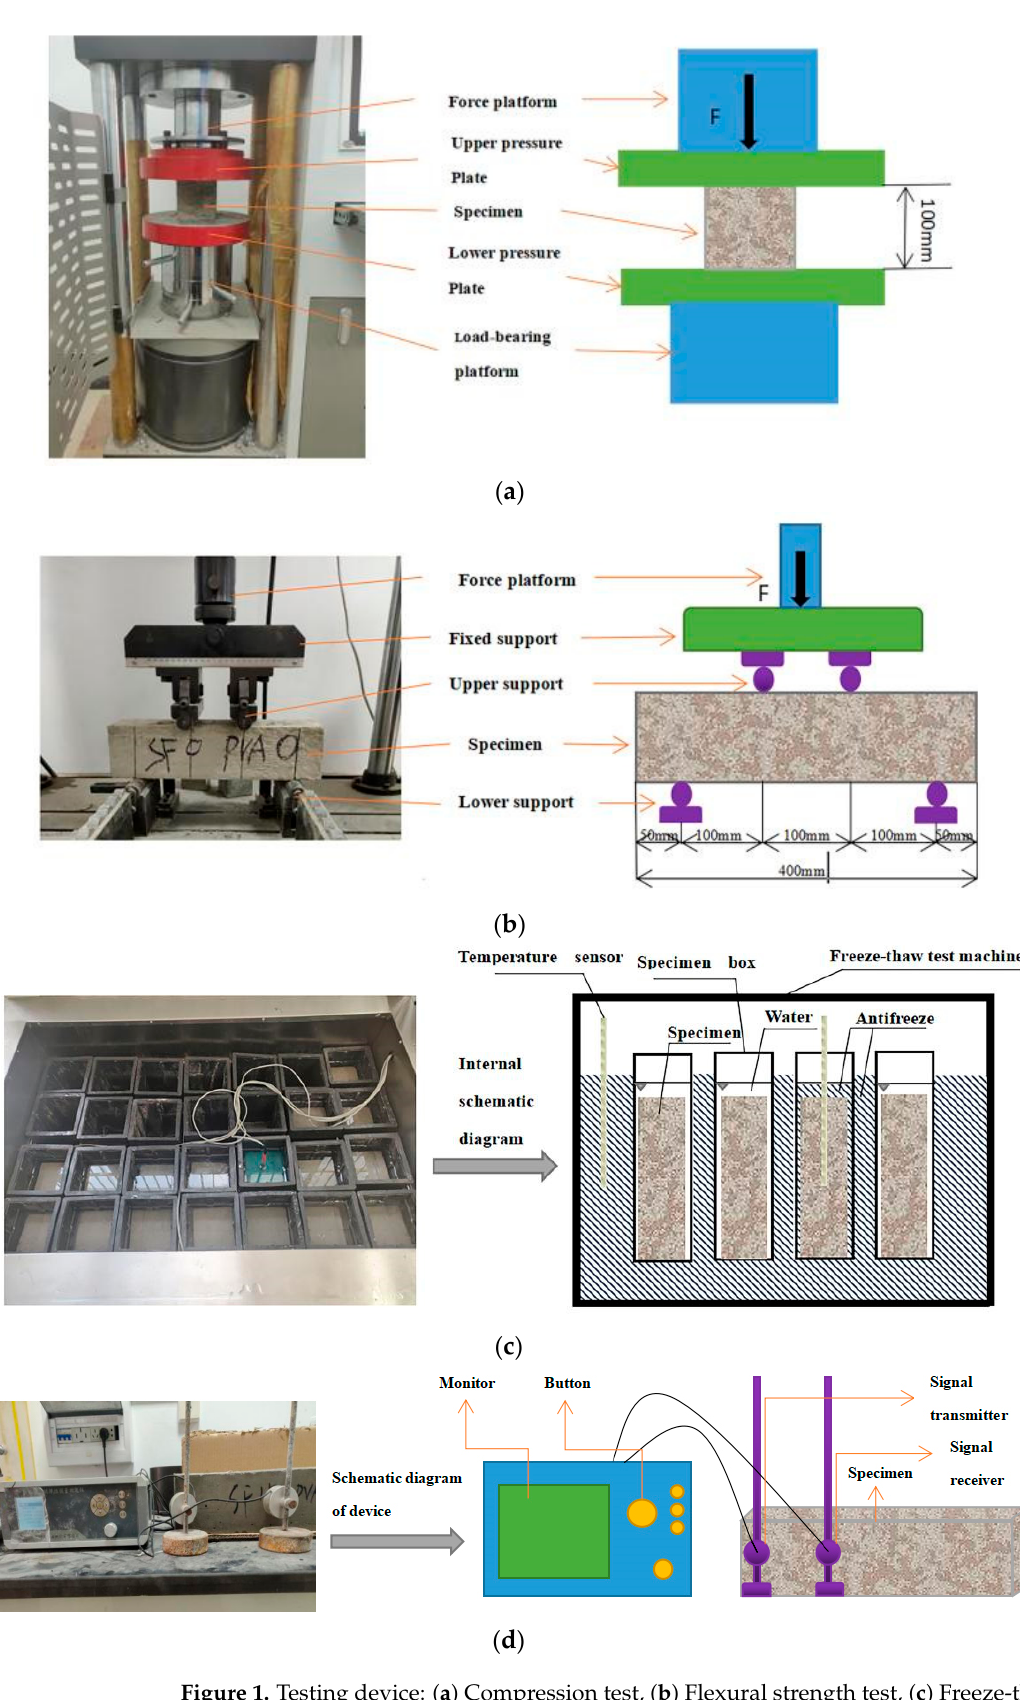
Figure 1. Testing device: ( a ) Compression test, ( b ) Flexural strength test, ( c ) Freeze-thaw cycle test, ( d ) Determination of dynamic elastic modulus.